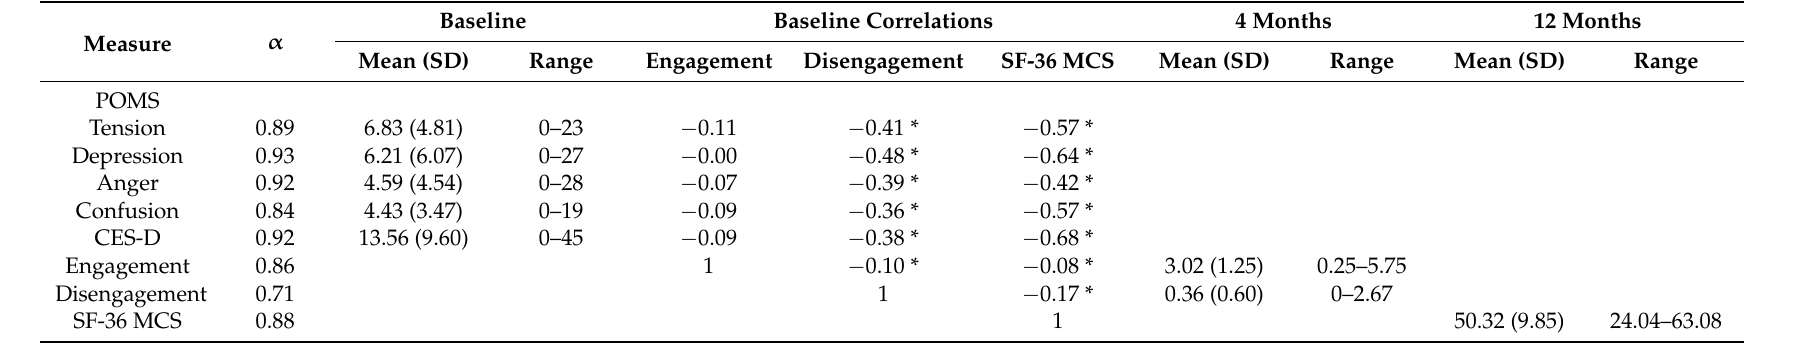
Table 1. Summary statistics (N = 122) and baseline correlations for emotion, ER, and